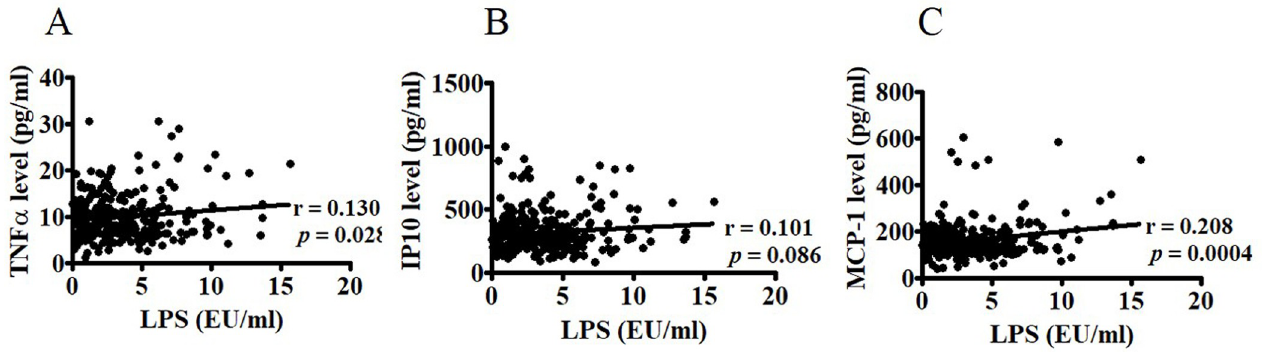
Fig 3. Associations between circulating endotoxin and inflammatory factors. Associations between circulating endotoxin levels and TNF- α (A), IP10 B), and MCP-1(C) in 289 postmenopausal women were determined using Spearman’s correlation analysis. TNF- α : tumor necrosis factor alpha; IP10: interferon- inducible protein-10; MCP-1: monocyte chemoattractant protein-1.